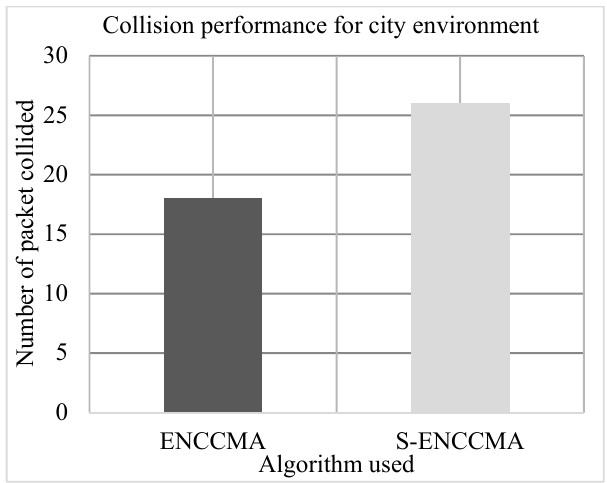
Figure 9. Collision performance achieved for a city environment.